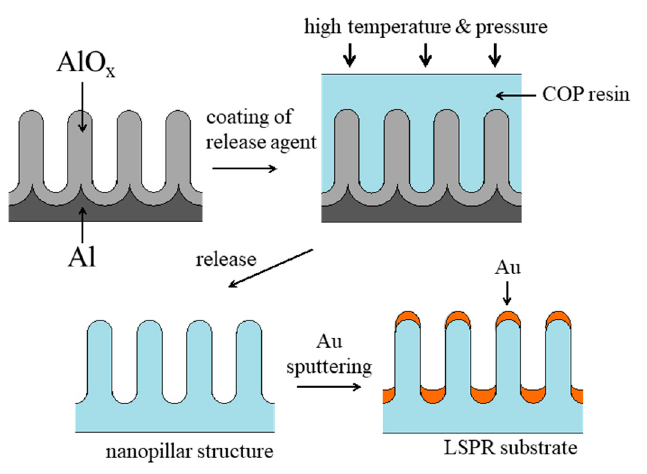
Figure 1. The used fabrication steps of the Au nanopillar structure [2].